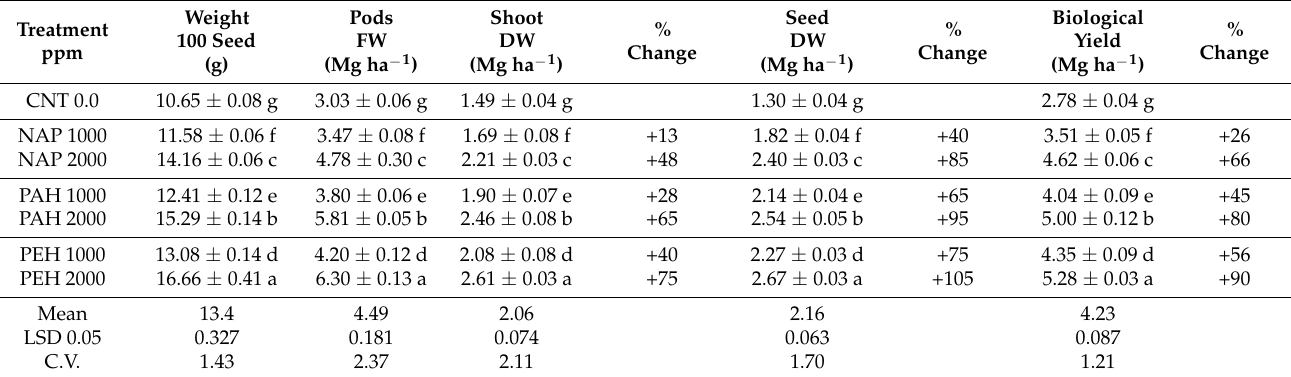
Table 6. Global field yields of Pisum sativum plans cultivated under normal clay loam soil conditions and treated with foliar spray of native whey protein (NAP), papain-hydrolyzed whey protein (PAH) or pepsin-hydrolyzed whey protein (PEH) at two different concentrations; 1000 and 2000 mg L − 1 , as compared to normal control (CNT) that received no foliar spray. Treatment